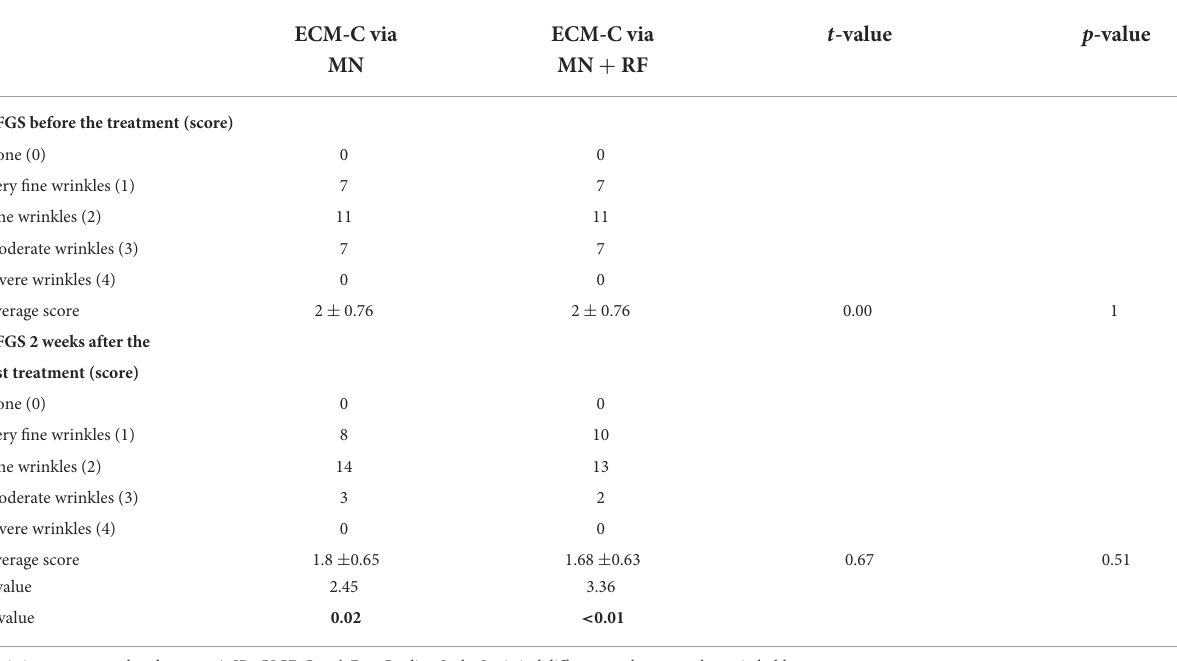
TABLE 4 CFGS assessment by the doctor.